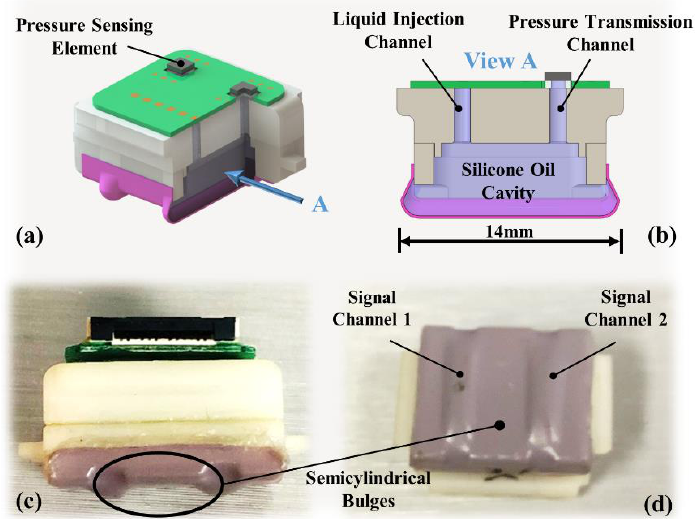
Figure 3. Sensing module details: ( a ) module structure schematic; ( b ) cross-section of the cavity; ( c ) side view of the sensing module; ( d ) semicylindrical bulge of the two channels. ( c ) side view of the sensing module; ( d ) semicylindrical bulge of the two